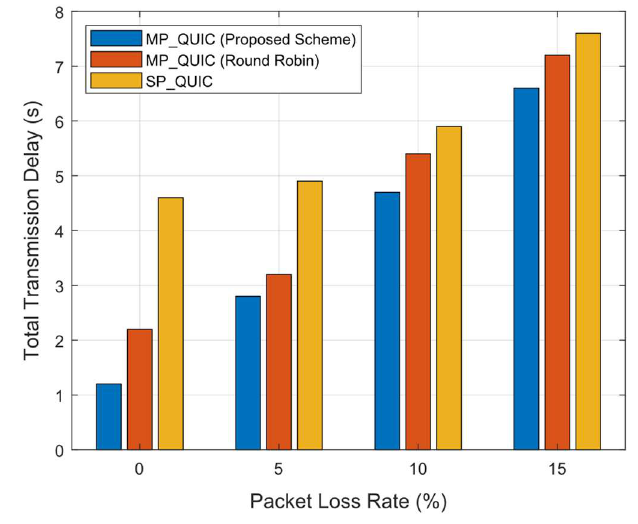
Figure 7. Total transmission delays for different packet loss rates.